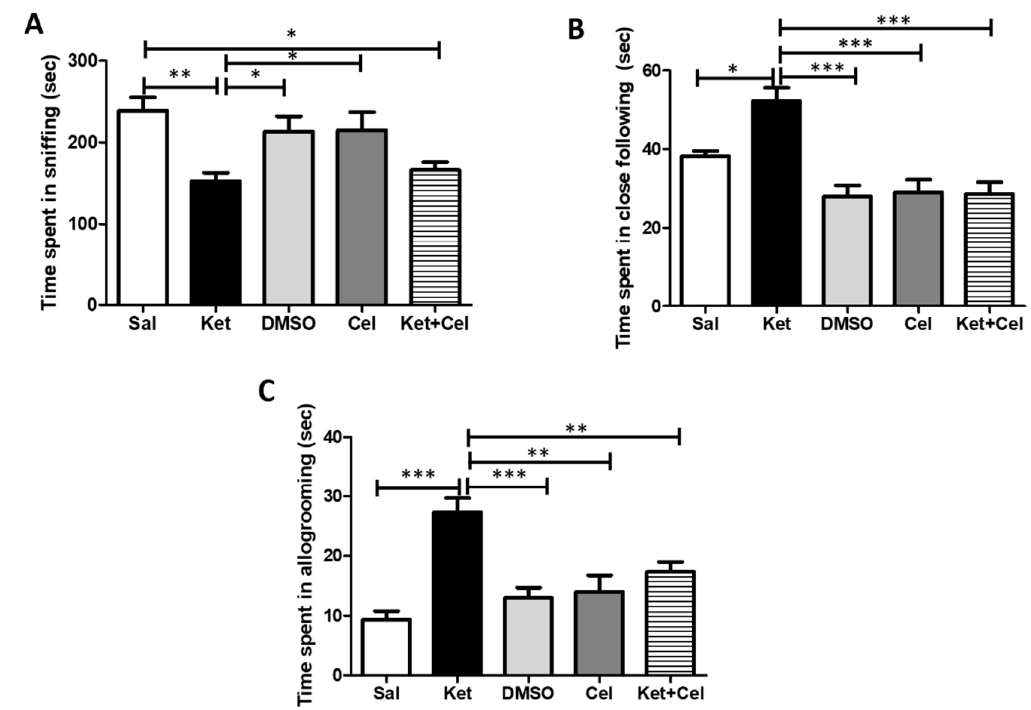
Figure 3. Celastrol administration in postnatal life prevented ketamine-induced social behavior dysfunctions in later adulthood. ( A ). Time spent in sniffing (seconds, sec) in adult mice receiving saline (Sal, n = 4) or ketamine (Ket, n = 8) or a 50% DMSO in PBS (DMSO, n = 4) or celastrol (Cel, n = 4) or ketamine + celastrol (Ket + Cel, n = 7) at PNDs 7, 9 and 11. One Way ANOVA, followed by Tukey’s post hoc test F = 6.856, ** p < 0.01; * p < 0.05. ( B ). Time spent in close following (seconds, sec) in adult mice receiving saline (Sal, n = 4) or ketamine (Ket, n = 7) or a 50% DMSO in PBS (DMSO, n = 4) or celastrol (Cel, n = 4) or ketamine + celastrol (Ket + Cel, n = 7) at PNDs 7, 9 and 11. One Way ANOVA, followed by Tukey’s post hoc test F = 13.10, *** p < 0.001; * p < 0.05. ( C ). Time spent in allogroming (seconds, sec) in adult mice receiving saline (Sal, n = 5) or ketamine (Ket, n = 6) or a 50% DMSO in PBS (DMSO, n = 4) or celastrol (Cel, n = 4) or ketamine + celastrol (Ket + Cel, n = 6) at PNDs 7, 9 and 11. One Way ANOVA, followed by Tukey’s post hoc test F = 12.50, *** p < 0.001; ** p < 0.01.